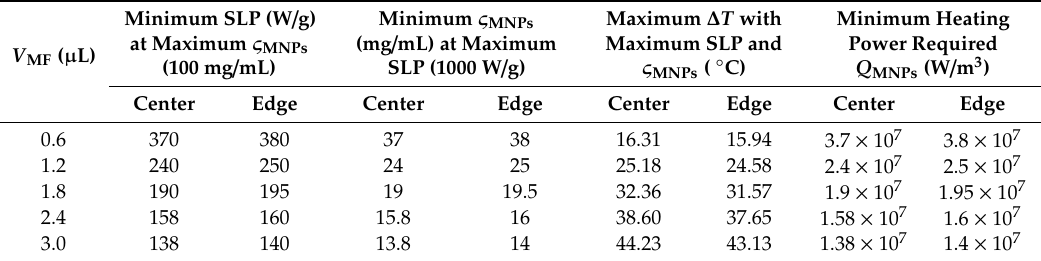
Table 2. The minimum amount of SLP, ς MNPs and heating power Q MNPs values required for WMS at di ff erent values of V MF with the consideration of BF and CSF from Figures 3 and